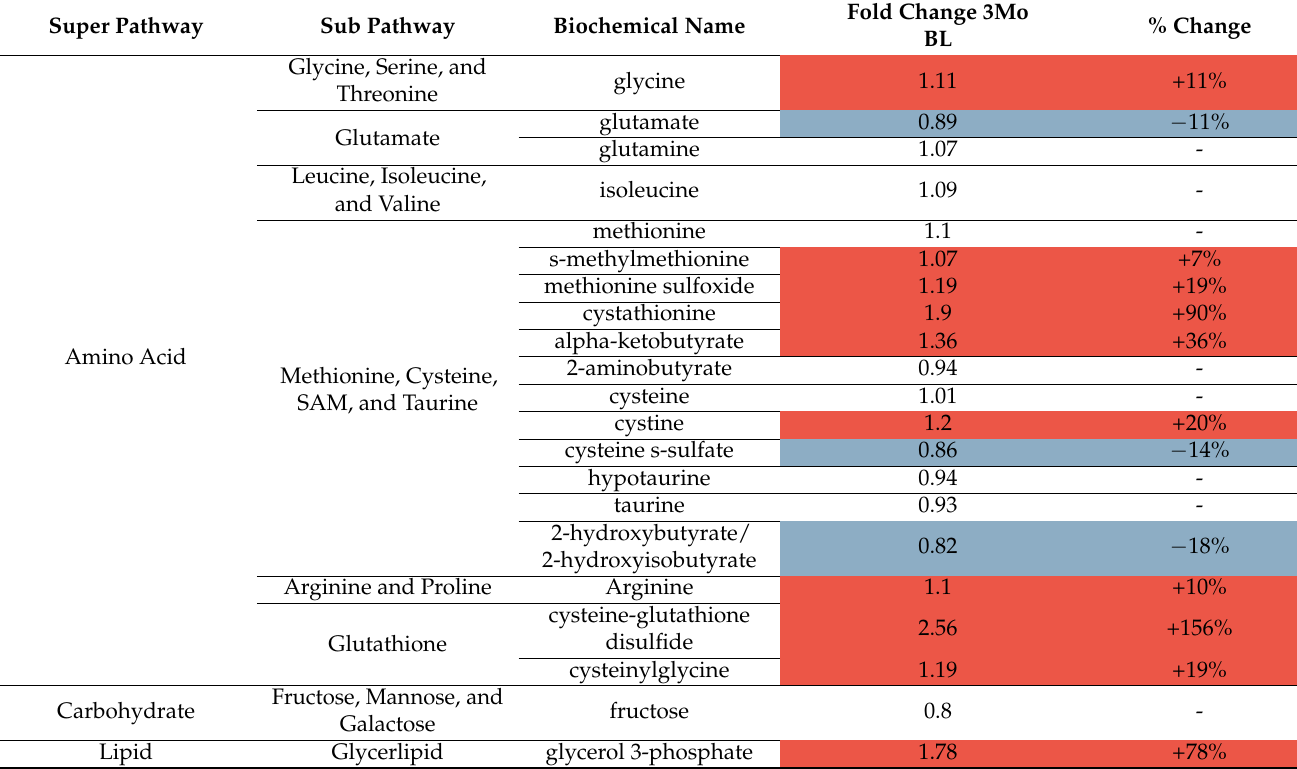
Table 4. Metabolites Related to Cellular Oxidative